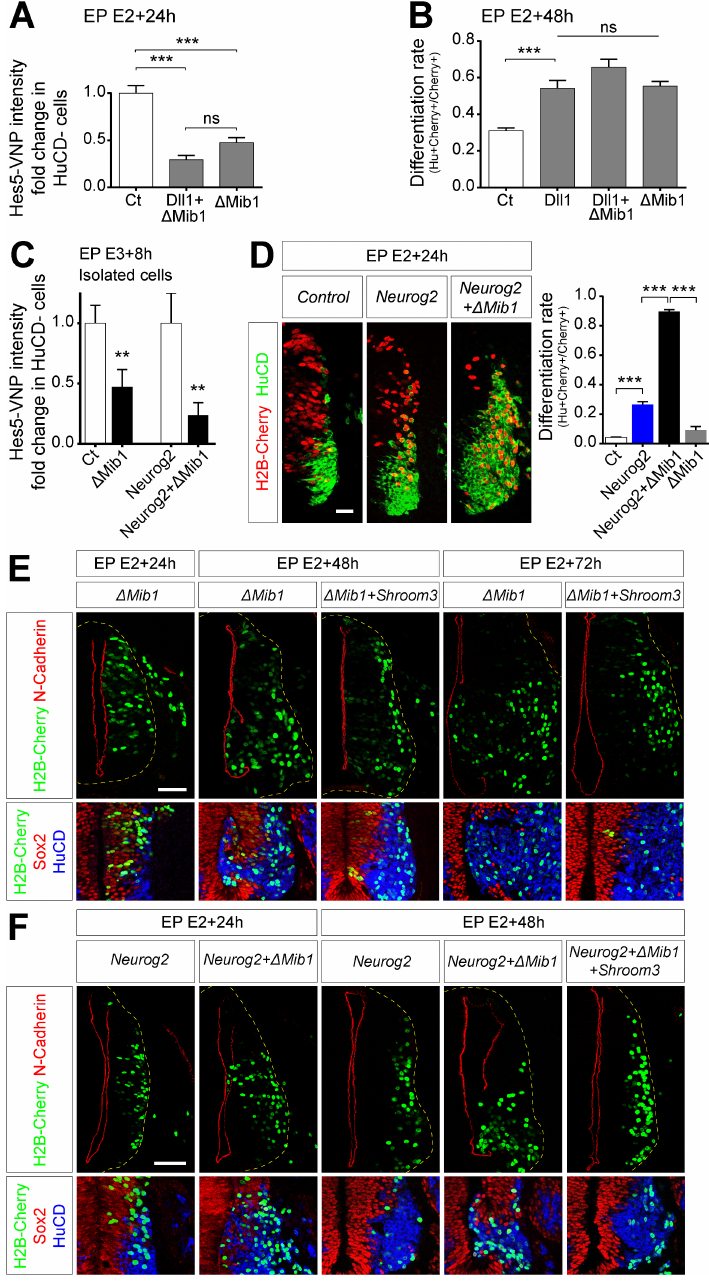
Fig 5. Mib1 blocks Notch Cis -inhibition to defer differentiation and preserve neuroepithelial integrity. (A) Quantification of Hes5-VNP intensity in HuCD − cells transfected with the indicated constructs at E2 and harvested 24 hae. Data represent fold change compared to control. A minimum of 108 cells were analyzed for each group. ns, p > 0.05; (cid:3)(cid:3)(cid:3) p < 0.001 (Kruskal-Wallis test). (B) Quantification of the differentiation rate (number of HuCD + cells on total transfected cells). Data represent mean + SEM. n = 12 (3 embryos), 13 (6 embryos), 15 (6 embryos), 12 (4 embryos) sections were analyzed for control, Dll1, Dll1+ Δ Mib1, and Δ Mib1, respectively. ns, p > 0.05; (cid:3)(cid:3)(cid:3) p < 0.001 (one-way ANOVA). (C) Quantification of the Hes5-VNP signal intensity in HuCD − and isolated cells transfected at E3 with the indicated constructs at low voltage (15 V) and harvested 8 h later. Data represent fold change compared to control. n = 37 (3 embryos), 31 (7 embryos), 15 (3 embryos), and 25 (4 embryos) cells were analyzed for control, Δ Mib1, Neurog2, and Neurog2+ Δ Mib1, respectively. (cid:3)(cid:3) p < 0.01 (Mann-Whitney U test). (D) Left: Transverse sections of the NT transfected at E2 with the indicated constructs, harvested at E3 and immunostained for HuCD (green) to label neurons. Transfection is reported by H2B-Cherry expression. Right: Quantification of the differentiation